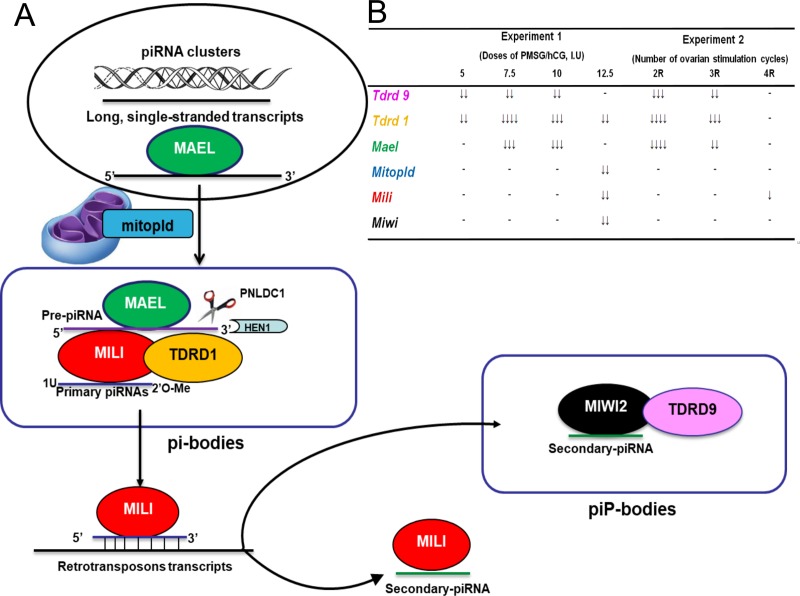
Schematic representation of the role of TDRD9, TDRD1, MAELLE, MITOPLD, MILI and MIWI proteins in the piRNA biogenesis and the effect of the ovarian stimulation on the gene expression.(A) Schematic illustration of the role of investigated proteins in the primary and secondary (ping-pong cycle) piRNA biogenesis. In the primary pathway, long, single-stranded transcripts (black) produced from piRNA clusters are processed by the endonuclease activity of mitochondrial protein MITOPLD, generating the pre-piRNAs (purple) with uridine at the first nucleotide position (1U) and are loaded onto MILI, a Nuage protein [10, 13, 16]. At these stages, the nucleocytoplasmic shuttling protein MAEL binds piRNA precursors and delivers them to pi-bodies that contain MILI and its binding partner TDRD1 [13, 15]. The 3’ end of pre- piRNAs is trimmed by a nuclease, PNLDC1, and modified by the methyltransferase HEN1 to generate mature primary piRNAs (blue). The mature primary piRNAs guide MILI to slice their complementary target RNAs such as retrotransposons transcripts and these processes cause the production of a series of secondary piRNAs (green) that associate with MILI and also MIWI2 (ping-pong cycle) [13,16]. MIWI2 and its interaction partner TDRD9 are found in piP bodies and don’t have a slicer activity, but the MIWI2–piRNA complexes can regulate gene transcription by epigenetic mechanisms including histone modification and DNA methylation of target genes [12, 13]. (B) Effects of OS on the expression of Tdrd9, Tdrd1, Mael, Mitopld, Mili, and Miwi. 1–2 (↓), 2–4 (↓↓), 4–8 (↓↓↓), and 8–15 (↓↓↓↓) times significantly decrease in the expression levels of studied genes compared to control.